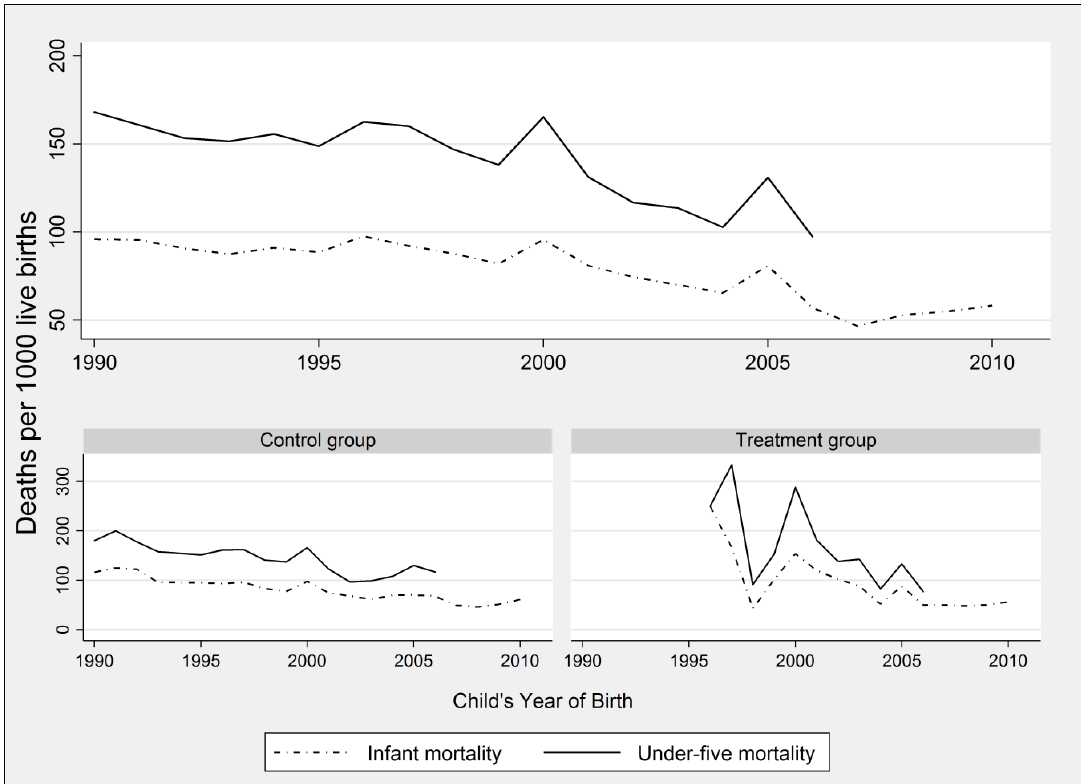
Figure 3. Child mortality trends by year of child’s birth for the overall, treatment and control groups.